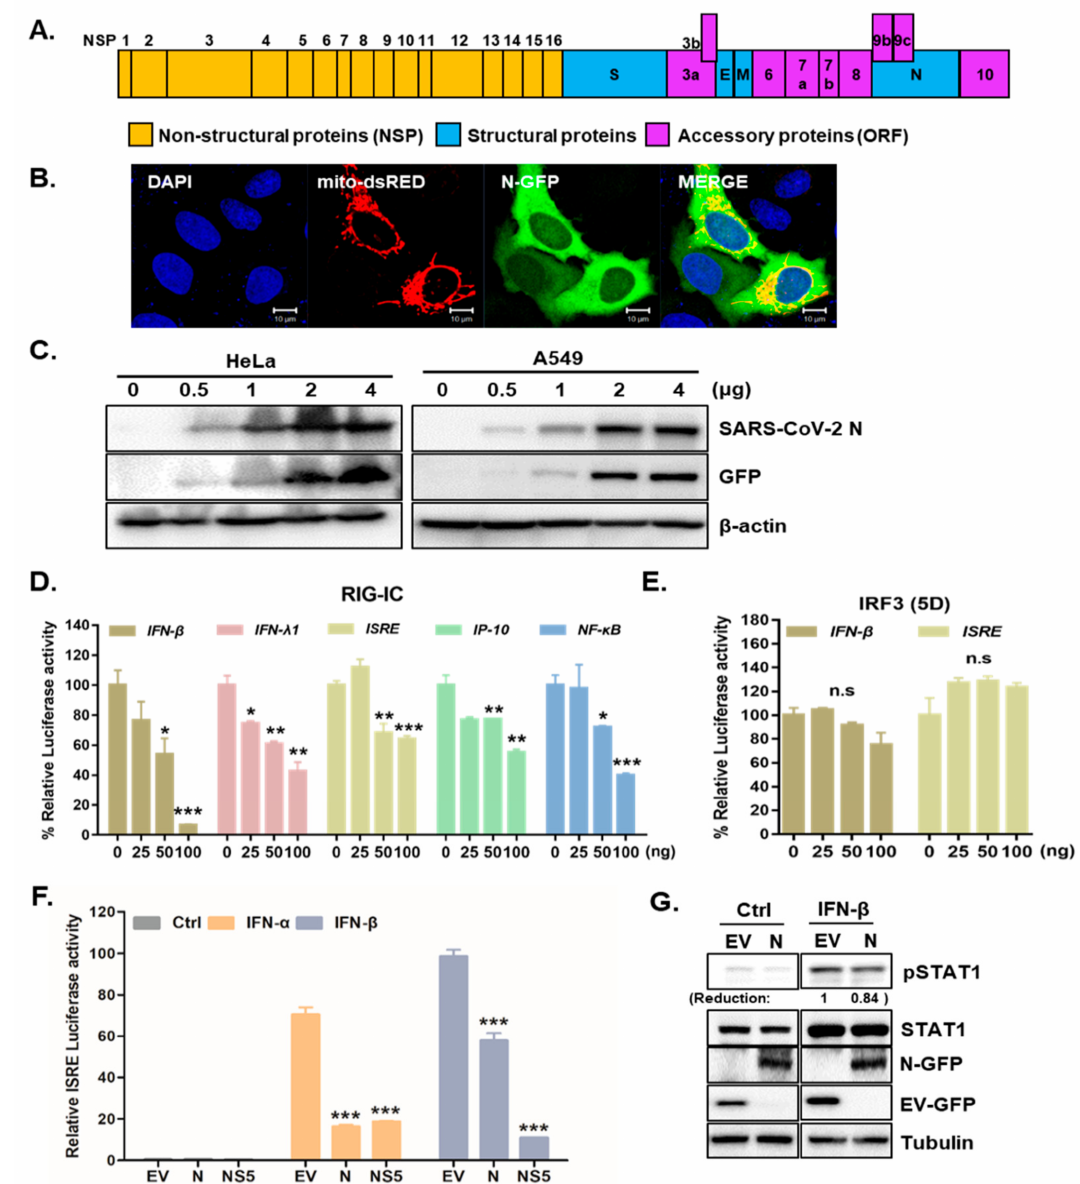
Figure 1. SARS-CoV-2 N is a potent interferon antagonist. ( A ) Schematic view of SARS-CoV-2 genome is shown. ( B ) HeLa cells were transfected with SARS-CoV-2 N-GFP-encoding and mito-dsRED plasmids. Scale bar = 10 µ m. ( C ) HeLa and A549 cells transfected with increasing amounts of SARS-CoV-2 N-GFP-encoding plasmids were immunoblotted with with the indicated antibodies to determine transfection efficiency. ( D , E ) HEK293T cells expressing RIG-IC, or IRF3 (5D) were co-transfected with firefly luciferase reporter plasmids encoding IFN- β , IFN- λ 1, ISRE, IP-10, and NF- κ B promoter together with increasing amount of SARS-CoV-2 N. The EV-GFP plasmid was used to ensure that each sample contains the same amount of total DNA plasmids. * p < 0.05; ** p < 0.01; *** p < 0.001, non-significant (n.s) versus EV-GFP-transfected cells ( F ) Recombinant IFN- α (50 ng/mL) or IFN- β (50 ng/mL) protein was added to the cells following the transfection with 100 ng of EV-GFP (EV), SARS-CoV-2 N (N) or ZIKV NS5 (NS5) encoding plasmids. Mean ± SD of three technical replicates are shown. *** p < 0.001 versus EV-GFP-transfected cells. ( G ) Immunoblot results of IFN- β -induced phosphorylation of STAT1 are shown. The images are representative of three independent experiments. Numbers indicate quantitative densitometric analyses of blot using ImageJ